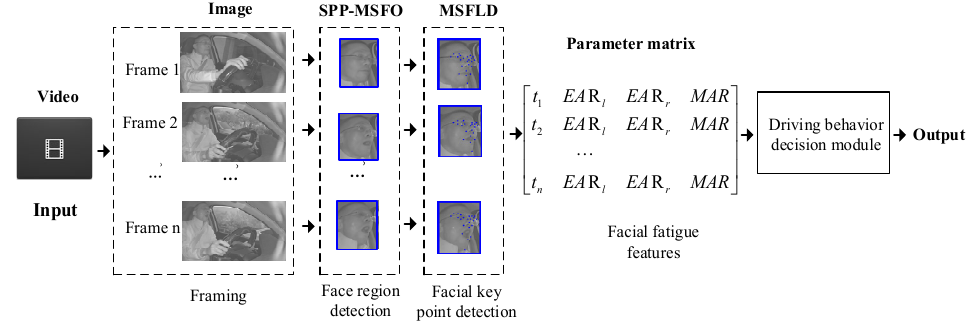
Figure 1. Architecture overview diagram of the proposed method.